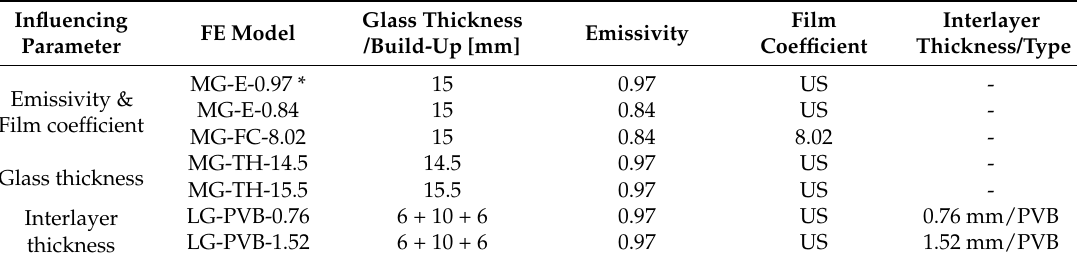
Table 2. Input properties for the 1D parametric models